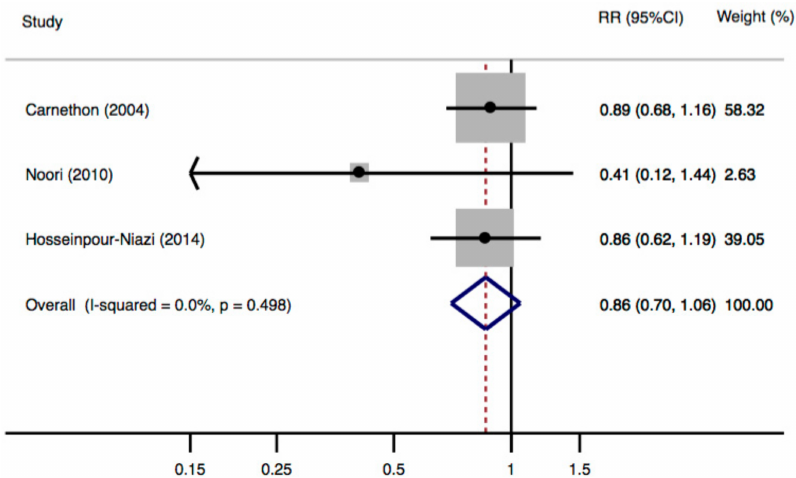
Figure 3. Meta-analysis of fiber intake (comparing the highest with the lowest fiber intake category) and the risk of metabolic syndrome for 3 independent samples from 3 cohort